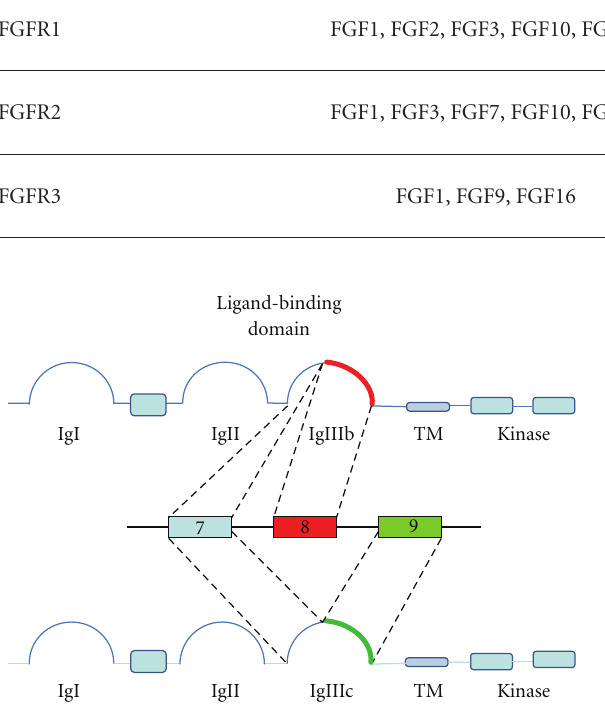
Figure 1: Schema splicing IIIb/IIIc. The extracellular domains of FGFRs consist of 3 Ig-like loops. The IgIII loops of FGFRs 1–3 are coded for by exons 7–9. Inclusion of exons 8 and 9 are mutually exclusive producing the IIIb and IIIc splice